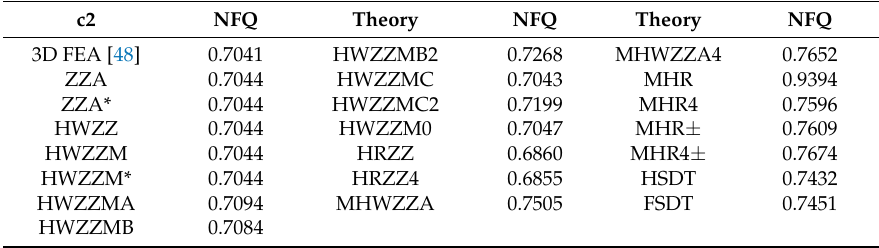
Table 9. Normalized fundamental frequencies (NFQ), case